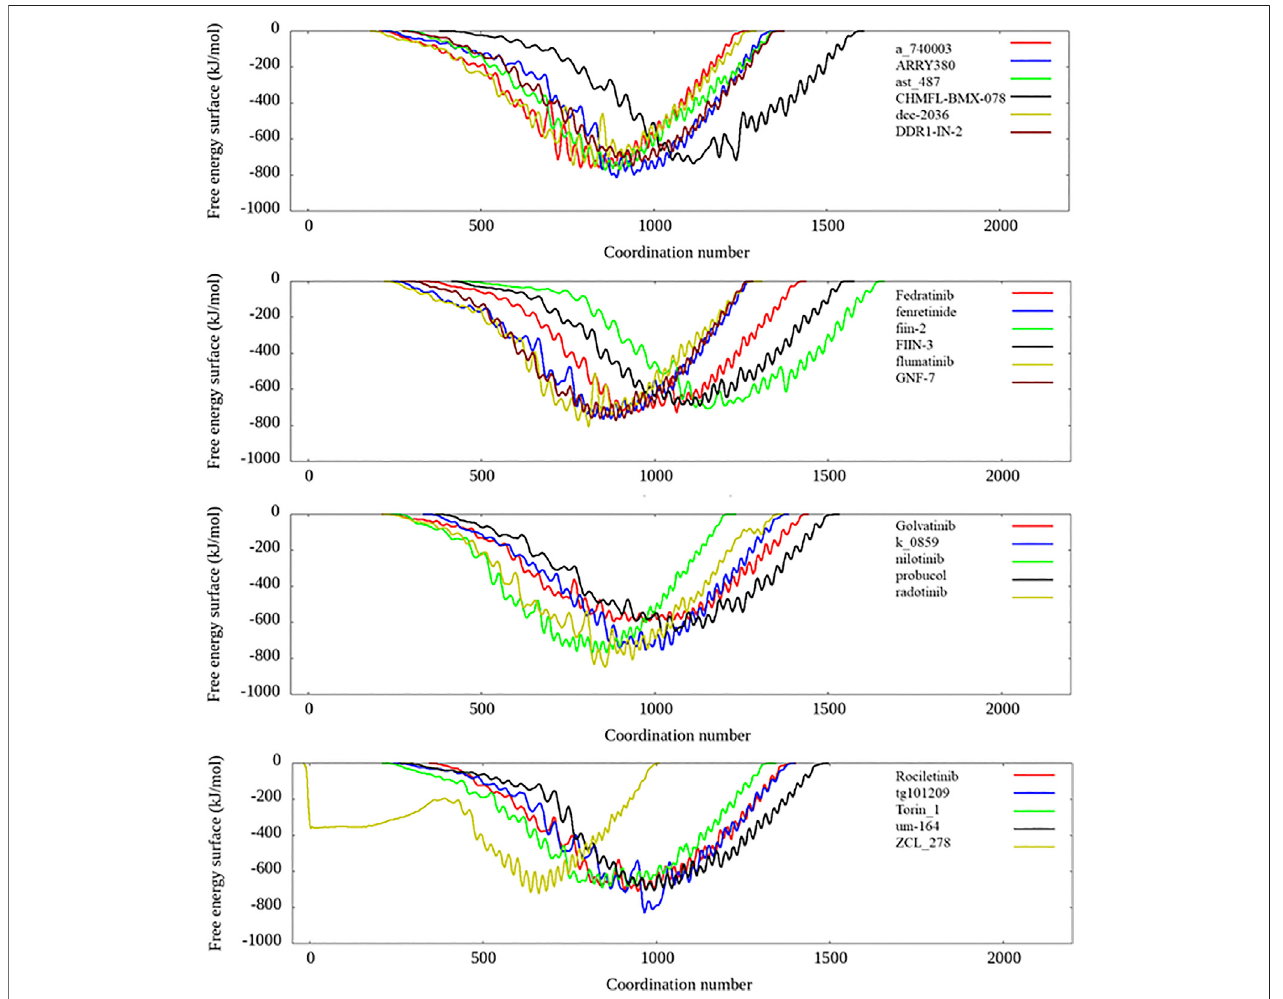
FIGURE 6 | The free energy landscape of several candidates from candidate lists 1 and